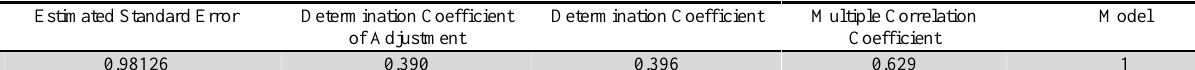
Analysis of hypotheses by means of multiple